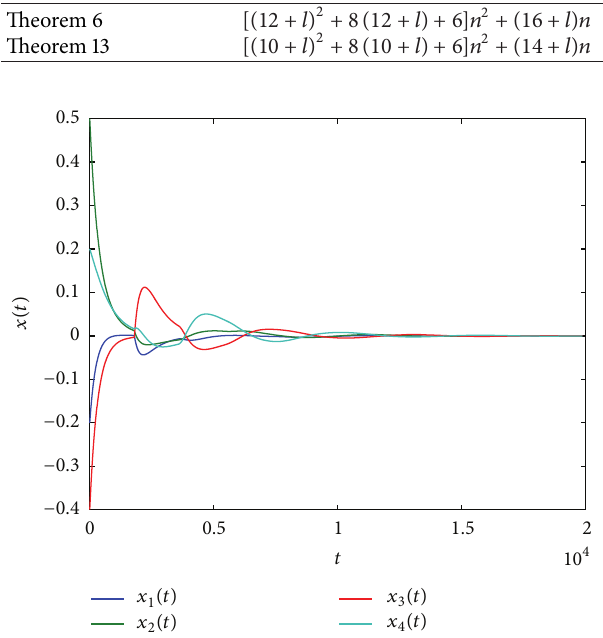
Figure5:ThesimulationofExample 4for ℎ = 5.19 ,wheretheinitial value is [−0.2, 0.5, −0.4, 0.2] 𝑇 , ℎ 𝐷 = 0.1